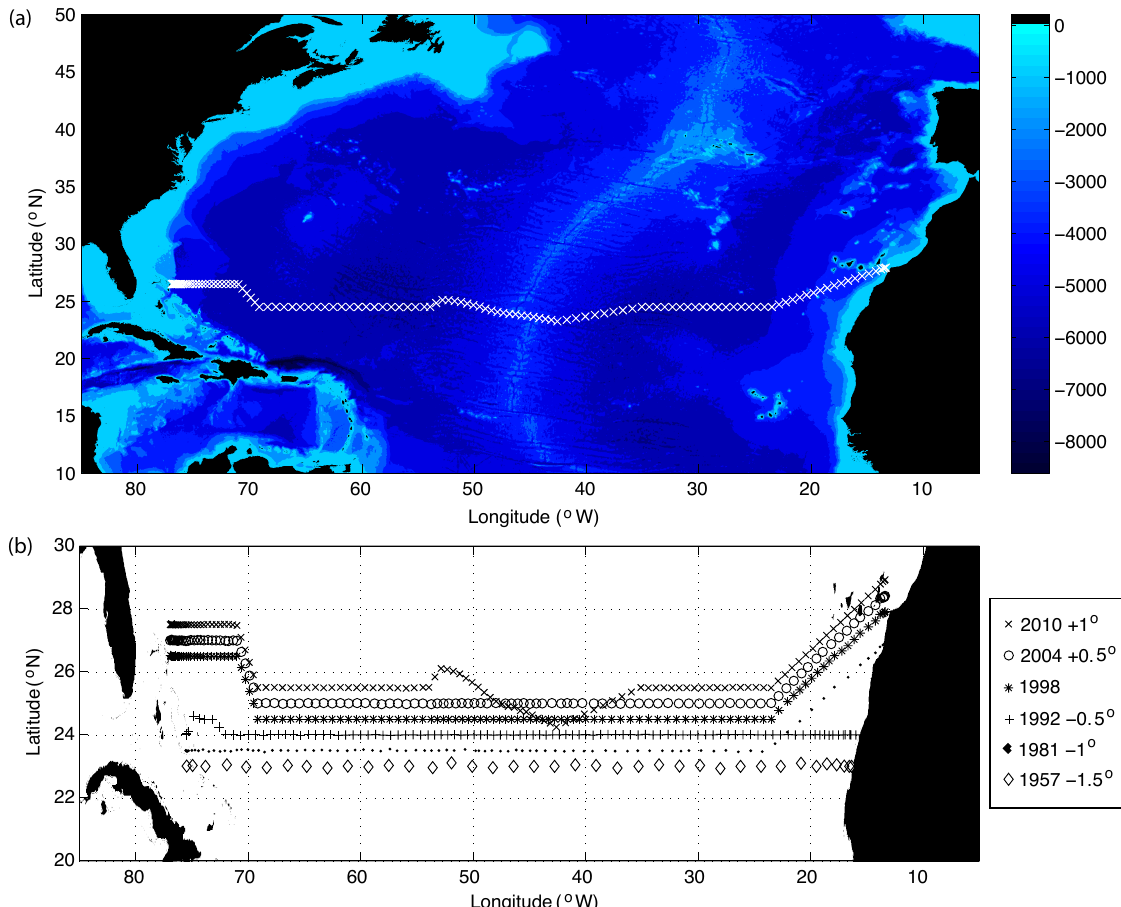
Fig. 1. (a) Bathymetric map (Smith and Sandwell, 1997) of the subtropical North Atlantic with mid-ocean CTD stations from the 2010 hydrographic cruise overlaid (b) CTD stations for the six hydrographic cruises completed across 25 ◦ N, note that cruise tracks are offset by 0.5 ◦ increments for clarity with 1998 at the correct